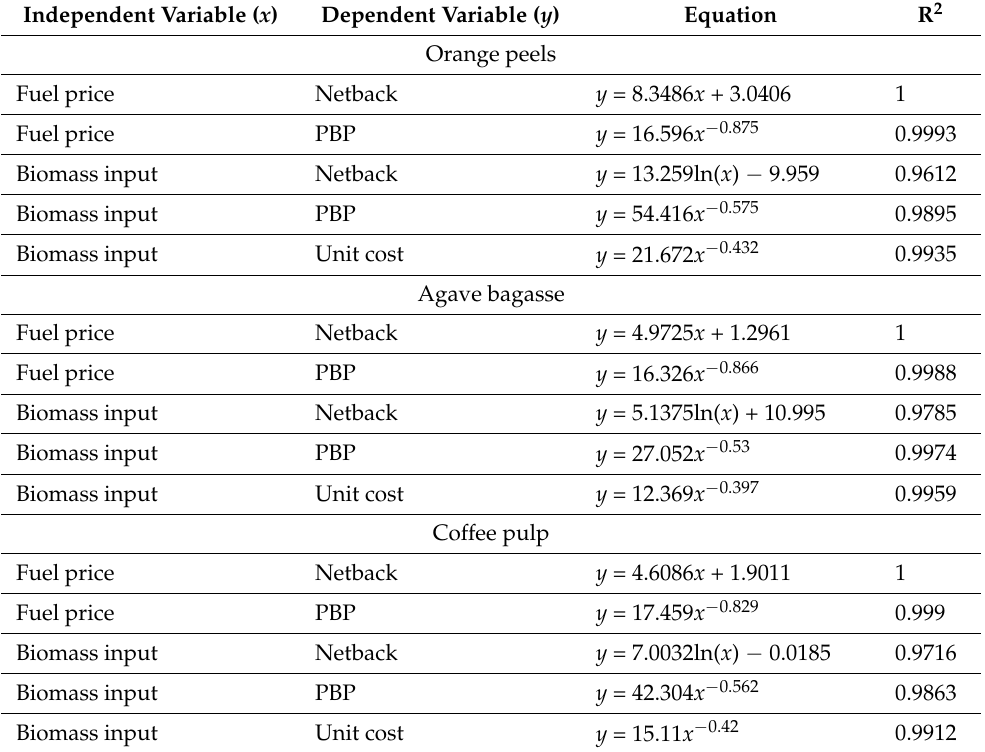
Table 5. Correlation parameters for the sensitivity